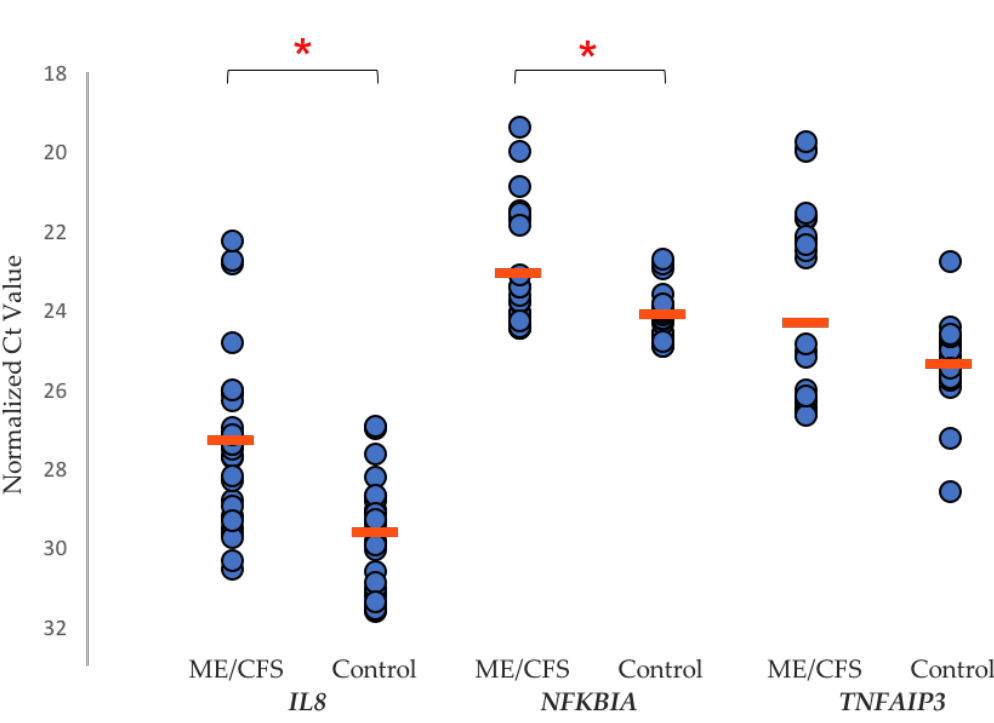
Figure 1. Scatter plot of RT-qPCR assay Ct values (defined below) for IL8 , NFKBIA , and TNFAIP3 . Each peripheral blood mononuclear cell (PBMC) sample (myalgic encephalomyelitis / chronic fatigue syndrome (ME / CFS) n = 10, control n = 10) was measured in triplicate, with the mean Ct value for each gene in both ME / CFS and control cohorts shown (orange line). A Ct value is the R everse T ranscription q uantitative P olymerase C hain R eaction (RT-qPCR) amplification cycle at which the gene transcript copy number exceeded the individually calculated baseline threshold level for that gene. Figure taken from our own recently published study [49]. Red bars indicate the mean Ct value in each case.